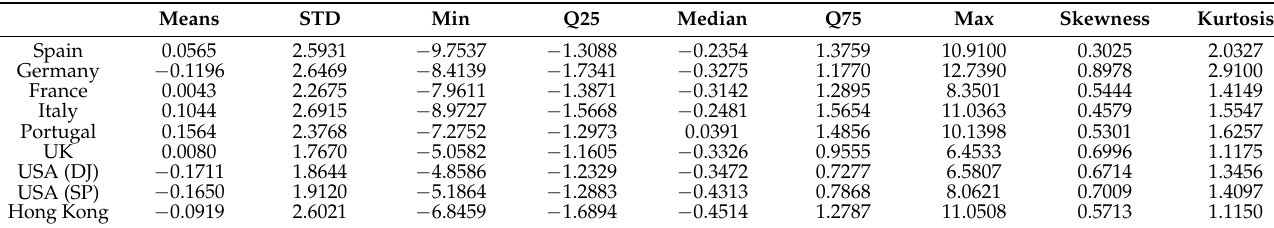
Table 5. Descriptive statistics of monthly losses in percentage: Means, Standard Deviation (STD), Minimum (Min), First Quantile (Q25), Median, Third Quantile (Q75), Maximum (Mas), Skewness and Kurtosis. Means